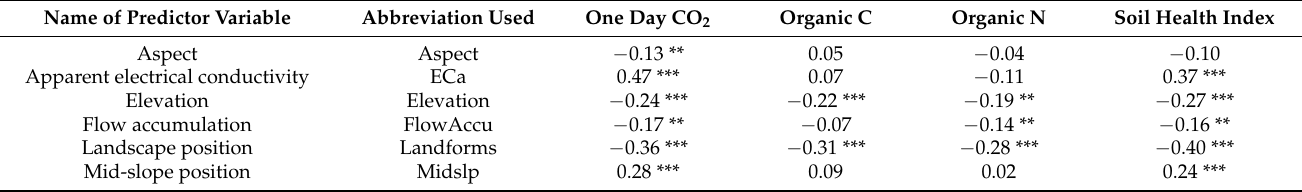
Table 1. Pearson’s correlation coefficient between measured soil properties, apparent electrical conductivity, and terrain